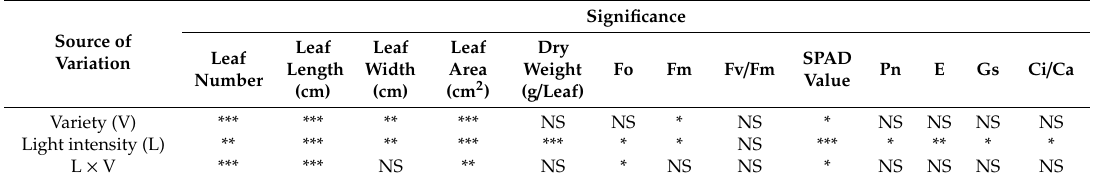
Table 1. ANOVA results of the main e ff ects of variety (V), light intensity (L), and their interaction e ff ect (L × V)ontheleafgrowthandphysiologicalparametersofofTainungNo. 1and Passiflorasuberosa